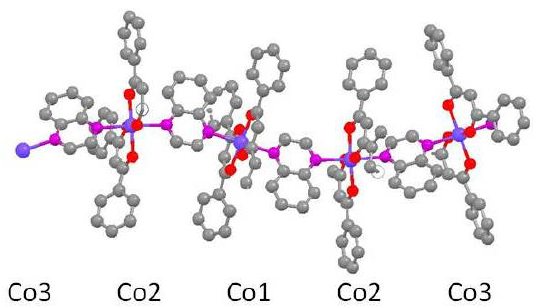
Figure 3. Ball-and-stick model of a portion of the wavelike chain of 2 showing the repeating arrangement of Co atoms in the chain. The hydrogen atoms are not included for clarity (C, gray; Co, blue; N, purple; O,